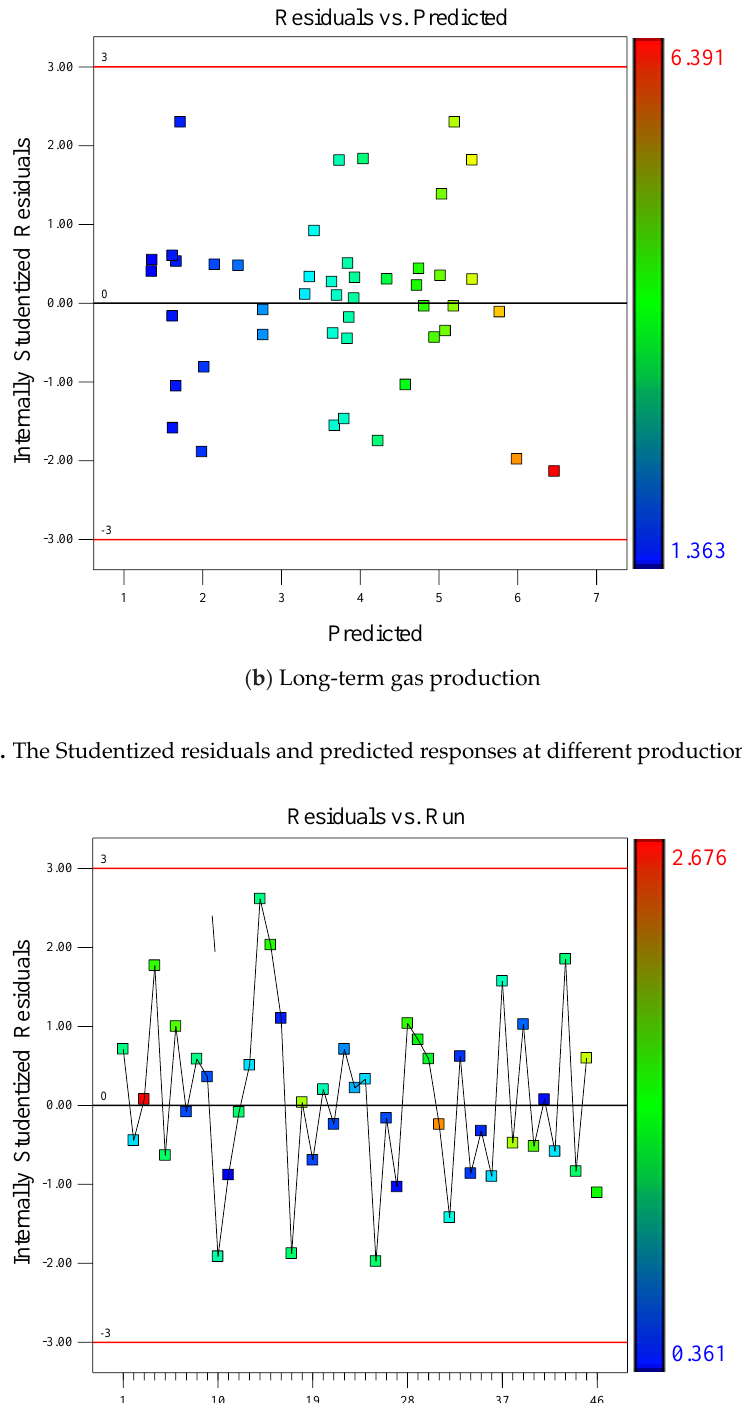
( a ) Short-term gas production Figure 11.